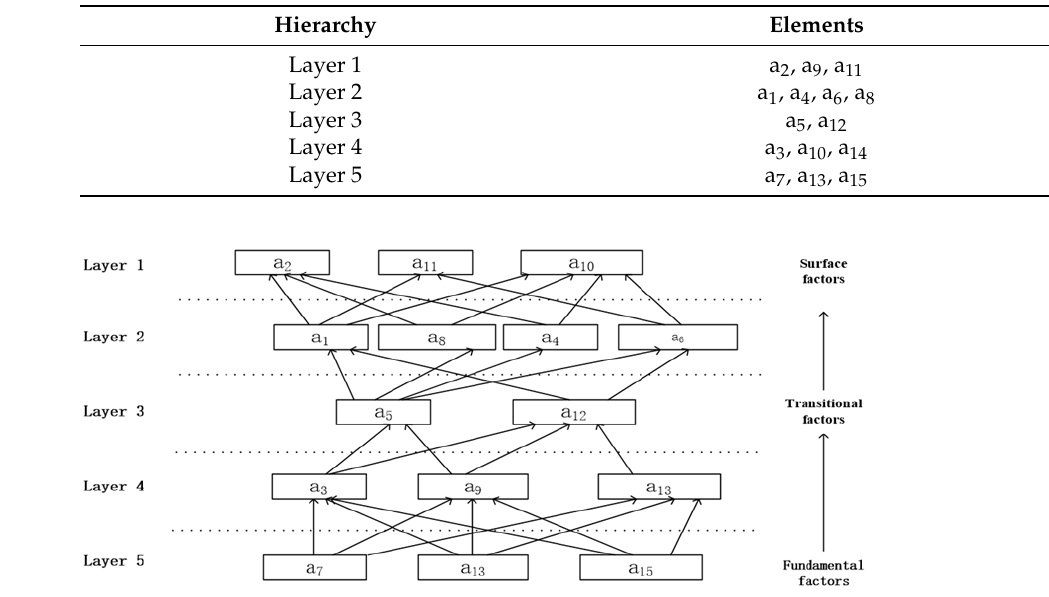
Figure 3. Directed Figure 3. Directed graph. Table 6. Hierarchical decomposition diagram.